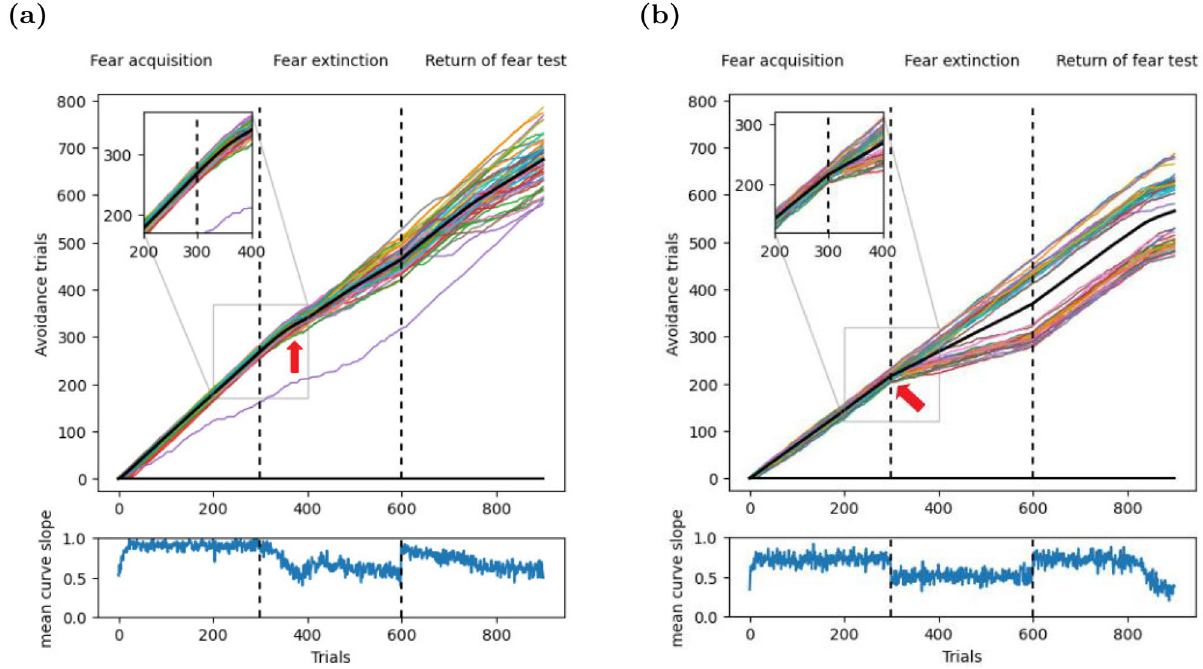
Figure 5. Dynamics of acquisition, extinction, and renewal-testing in T-maze. ( a ) Top: Cumulative response curves (CRCs) in an operant ABA renewal paradigm in the T-maze. Shown are 50 simulated CRCs (colored lines), and the mean CRC (black line). The inset shows the beginning of the extinction phase in context B, where the CRCs continue with the same slope as at the end of the acquisition phase in context A. This indicates that the association learned in context A generalized to context B. The red arrow points where the slopes start to change. Bottom: The slope of the mean CRC reveals rapid acquisition, gradual extinction learning, and renewal. ( b ) Top: In contrast to our model, Redish et al.’s model 17 changes its behavior immediately upon the switch from context A to context B (red arrow). Hence, this model does not generalize the learned association from context A to context B. In addition, one group of CRCs does not exhibit any extinction learning, and hence no renewal. Bottom: The slope of the mean CRC shows the sudden change in behavior at the onset of the extinction